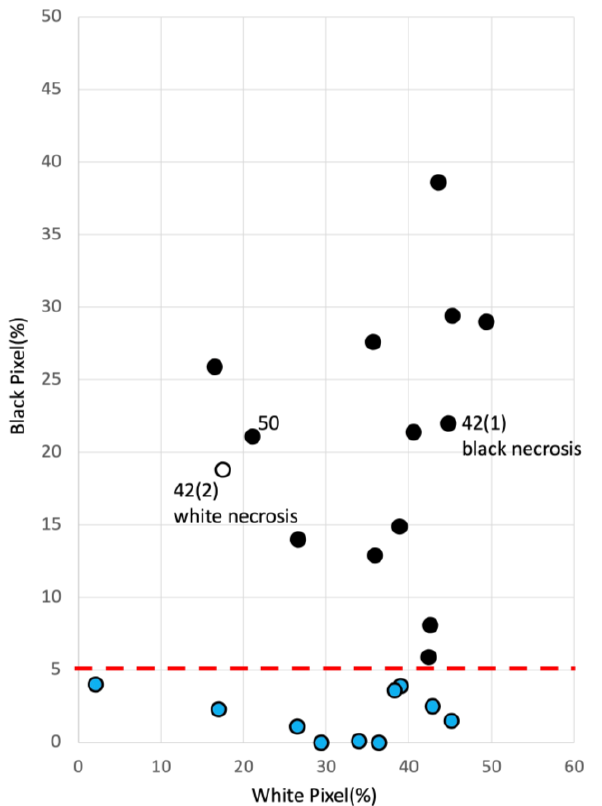
Figure 4. Twenty-three cases aligned on the chart with black and white pixels. Patients were divided into three groups based on physician judgment: black necrosis group (black circle), white necrosis group (white circle), and no necrosis group (blue circle). As per the algorithm depicted in Figure 1, we defined a black pixel percentage of more than 5% as necrotic and less than 5% as necrotic. We confirmed that with necrosis and without necrosis groups were separated, based on 5% black pixels. Table 6. The validation of determination of necrosis with medical specialists vs. image identification algorithm. Diagnosed by Image Identification Algorithm With Necrosis No Necrosis With necrosis 14 0 Diagnosed by medical specialists No necrosis 0 10 Fisher’s exact test, p = 5.10 × 10 − 7